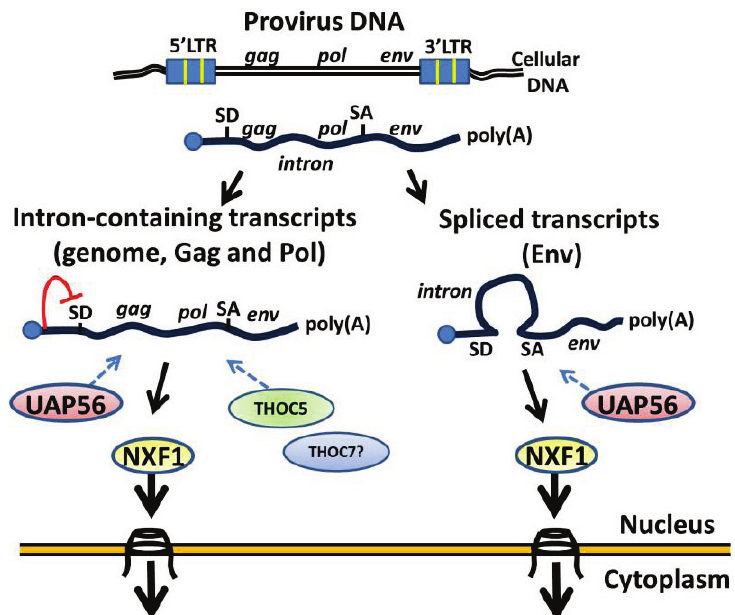
Figure 4. A model of gammaretroviral RNA export. Both unspliced and spliced transcripts require UAP56 and NXF1. THOC5 and THOC7 are required for the nuclear export unspliced viral transcripts. SD: splice donor; SA: splice